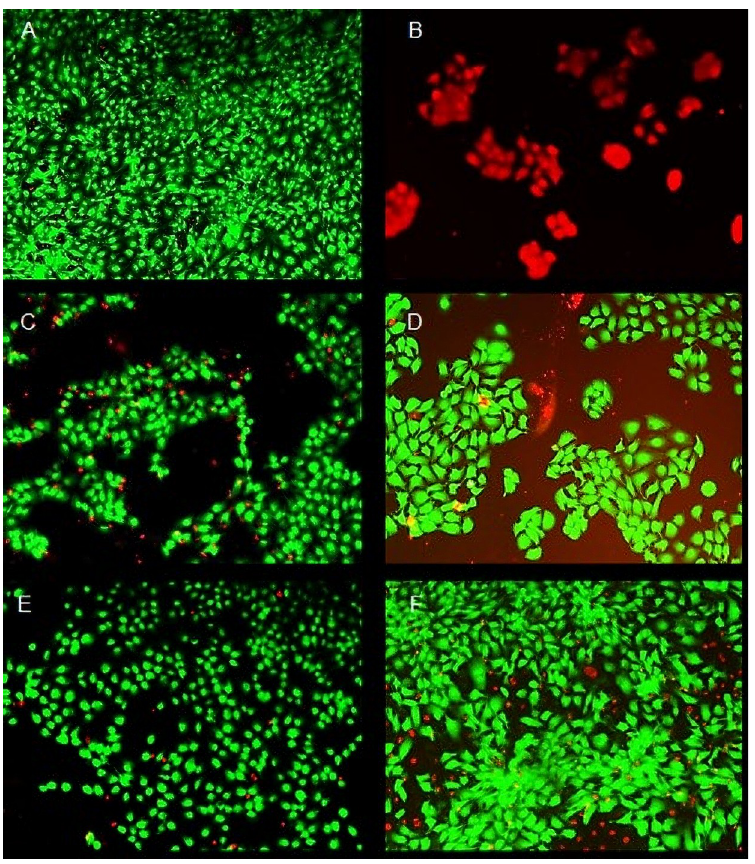
Fig 3. Fluorescence images showing the viability of the HaCaT cells treated with articaine formulations at the IC 50 concentration for 24 h at 37˚C. (A) live cells (negative control); (B) dead cells (positive control treated with 70% methanol); treatments with (C) ATC; (D) ATC epi ; (E) ATC nano ; (F) ATC nanoepi . Each image is composed of two superimposed images taken through different filters for green (calcein) and red (homodimer-1) fluorescence. All images were acquired at the same magnification (10x).